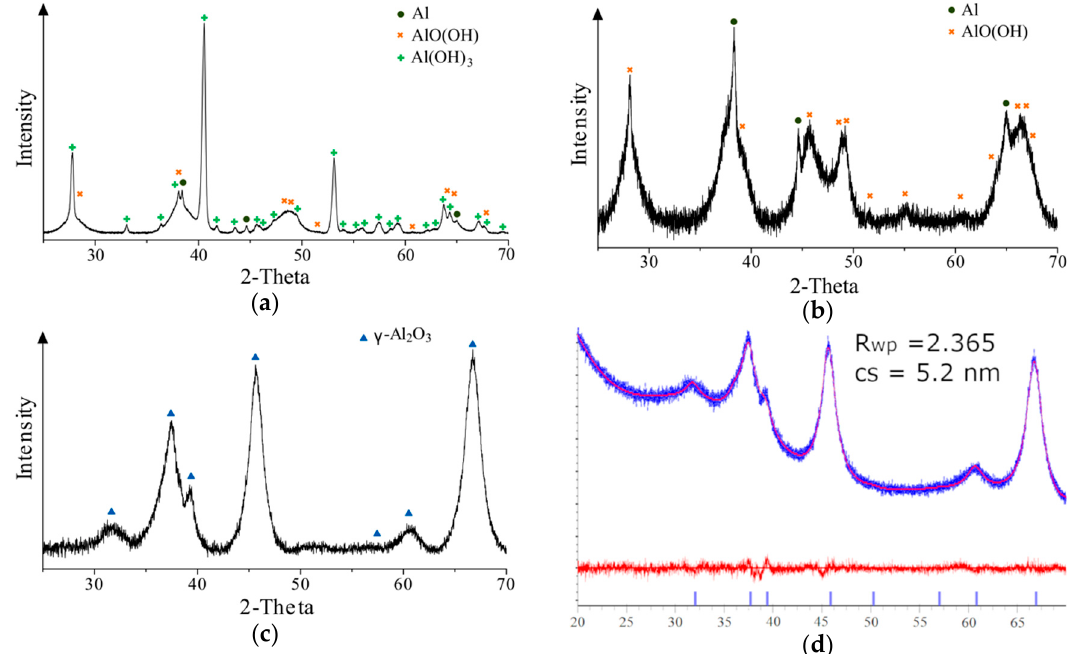
Figure 4. XRD results: ( a ) the byproduct after aluminum/water reaction, ( b ) aluminum hydroxide transformed into boehmite after heating at 280 °C, ( c ) gamma alumina after heating at 500 °C and ( d ) crystallite size calculation of gamma alumina using Topas software.